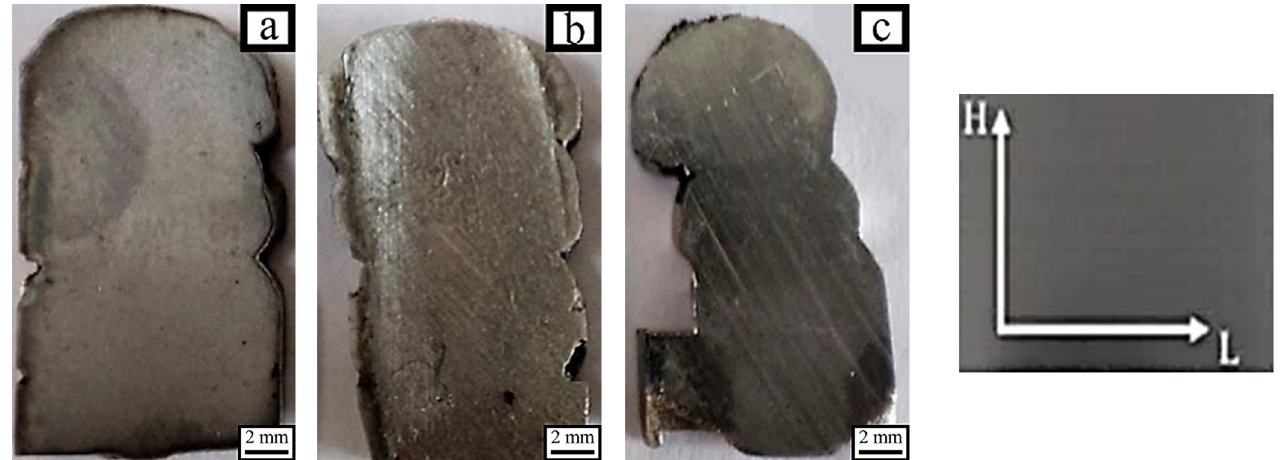
Figure 6. Images of specimens from cross-sections of investigated workpieces: ( а ) specimen № 1; ( b ) specimen № 2, ( c ) specimen № 3.